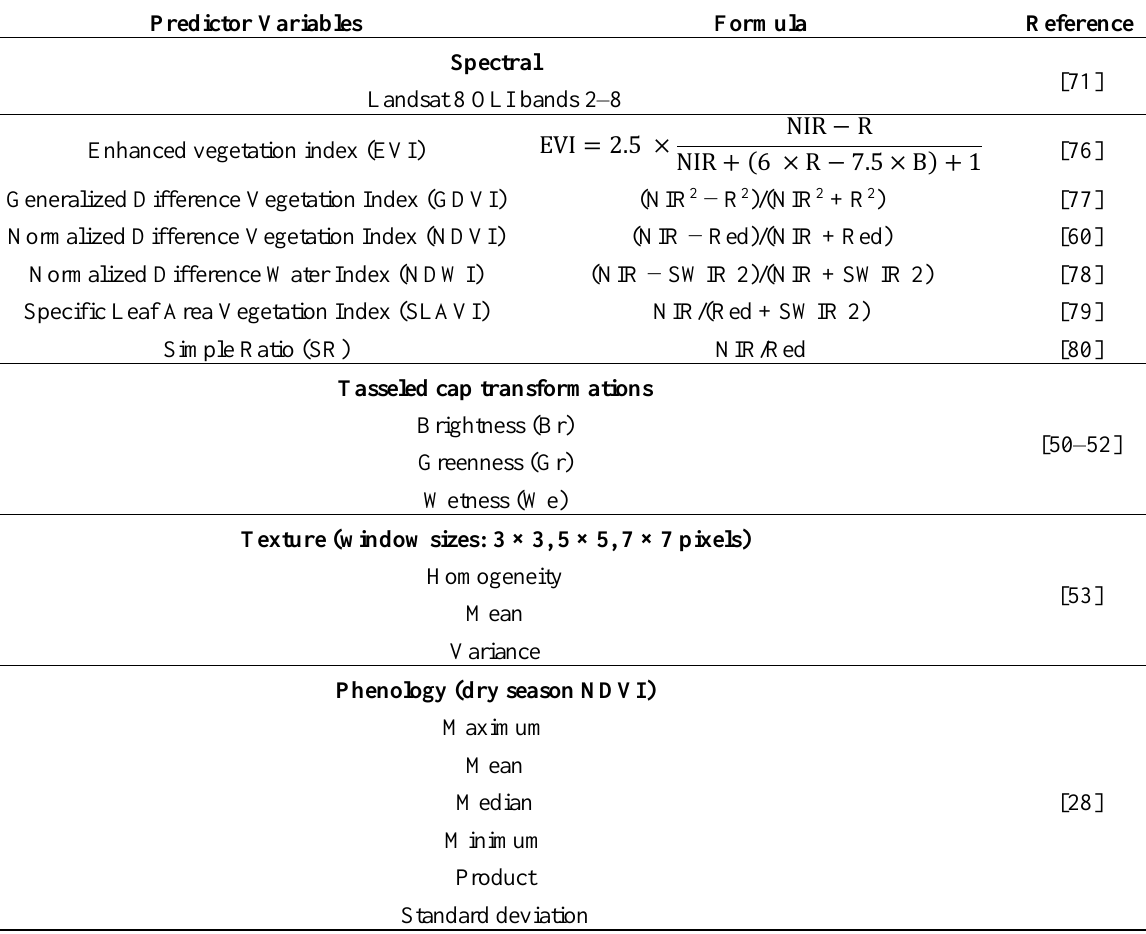
Table 4. Summary of the three types of predictor variables (spectral, texture, and phenology) included in predictive modeling of tree canopy cover and aboveground biomass.